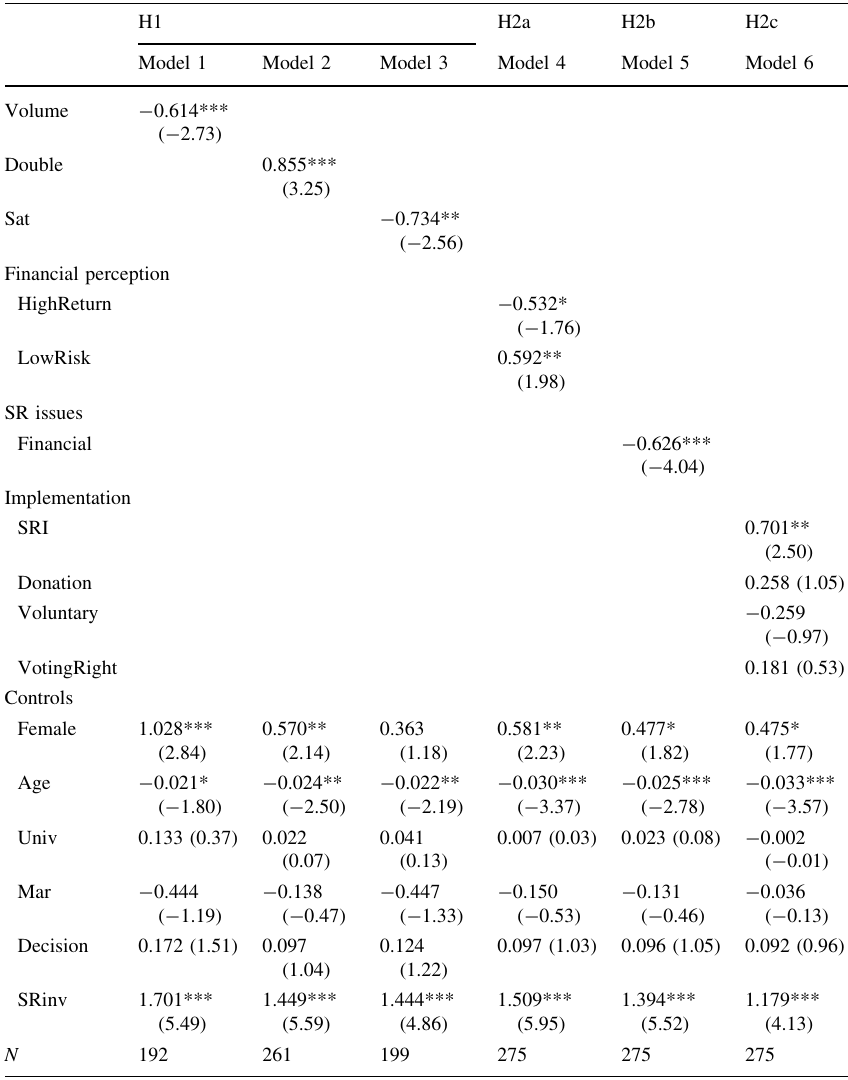
Table 7 Regression results on the optimal level of SR